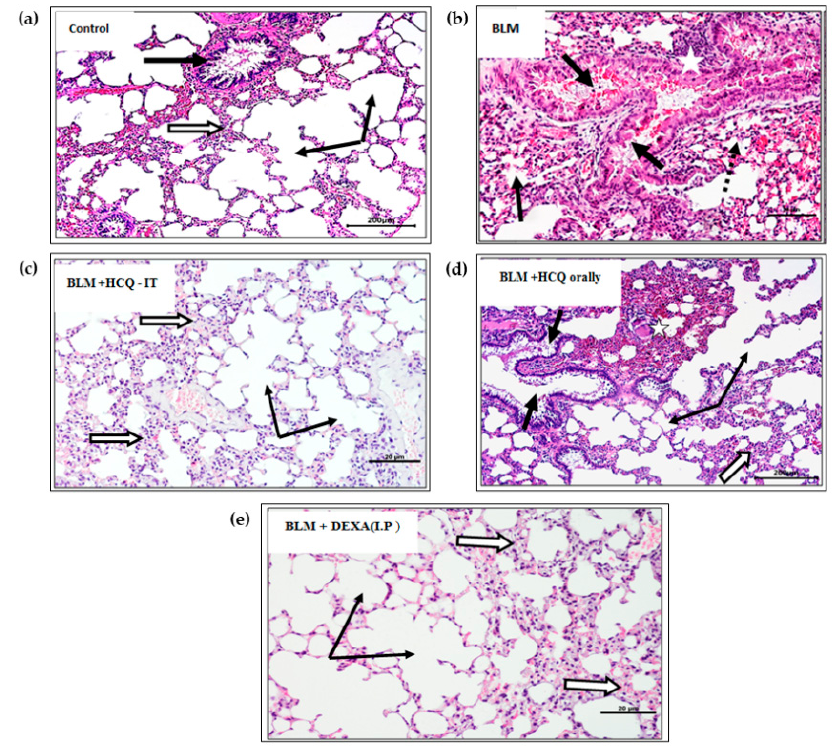
Figure 5. Sections of lung tissues stained by H&E and photographed at X100 (Bar = 200 µm) after administration of HCQ-NLC IT compared with different control groups. ( a ) Control group: The alveoli were free of any inflammatory cells, normally opened (thin black arrows), and separated by thin inter-alveolar septa. A nearby bronchiole showed a normal lining and empty lumen (white arrow). ( b ) BLM: Bronchioles (thick black arrows) contained epithelial lining degeneration with desquamation and hemorrhages that block their lumina (white stars). The alveoli showed marked disorganization and looked collapsed or filled with inflammatory cells. A congested capillary was observed (dotted arrows). ( c ) BLM + HCQ-NLC (IT): Opened alveoli free of any inflammatory deposits were shown. The only focal thickening of the inner-alveolar septa was shown (white arrows). ( d ) BLM + HCQ orally: A moderate improvement was shown, with opened alveoli, but many foci of inflammatory cell aggregates were closing nearby alveoli (white star). Bronchioles contained scanty exudates (black arrow). ( e ) BLM + DEXA (IP): A marked improvement was shown, with thin interalveolar septa and few connective tissue cells (white arrow).